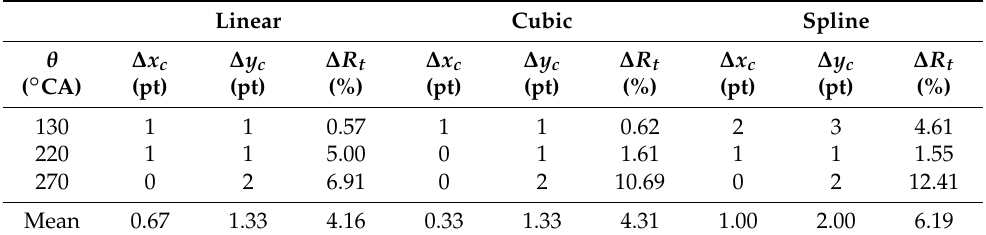
Table 3. Comparison between mean and interpolated fields of points outside the POD. Linear